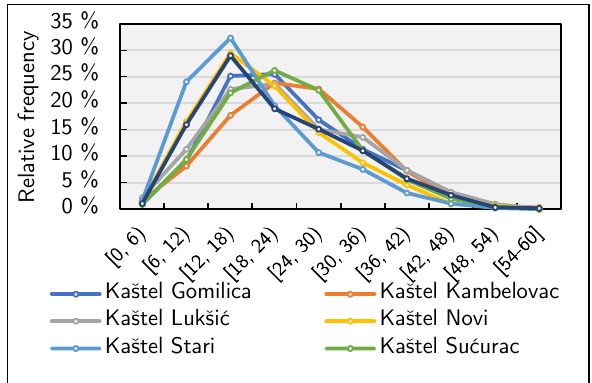
Figure 7. Relative frequency polygon of the GVI values in each of the seven settlements